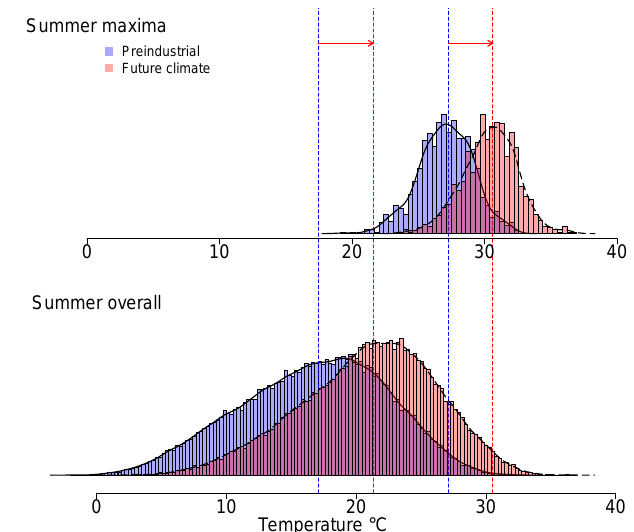
Figure A1. As in Fig. 1 but for summer warm extremes. Bottom: overall distribution of summer (JJA) daily maximum temperature ( T max ) in a northern Idaho location, for baseline and 700ppm CO 2 climate states. Top: distributions of seasonal maxima of summer T max . Note that the median shift of the overall distribution is now slightly larger than that of the distribution of extremes; the opposite was true for winter cold